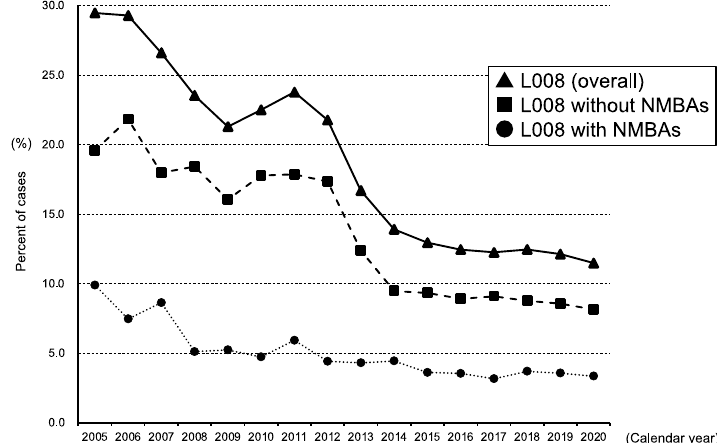
Figure 2. Annual rates of general anesthesia claim code (L008) with and without neuromuscular blocking agents (NMBAs) in total cesarean delivery cases from 2005 to 2020.